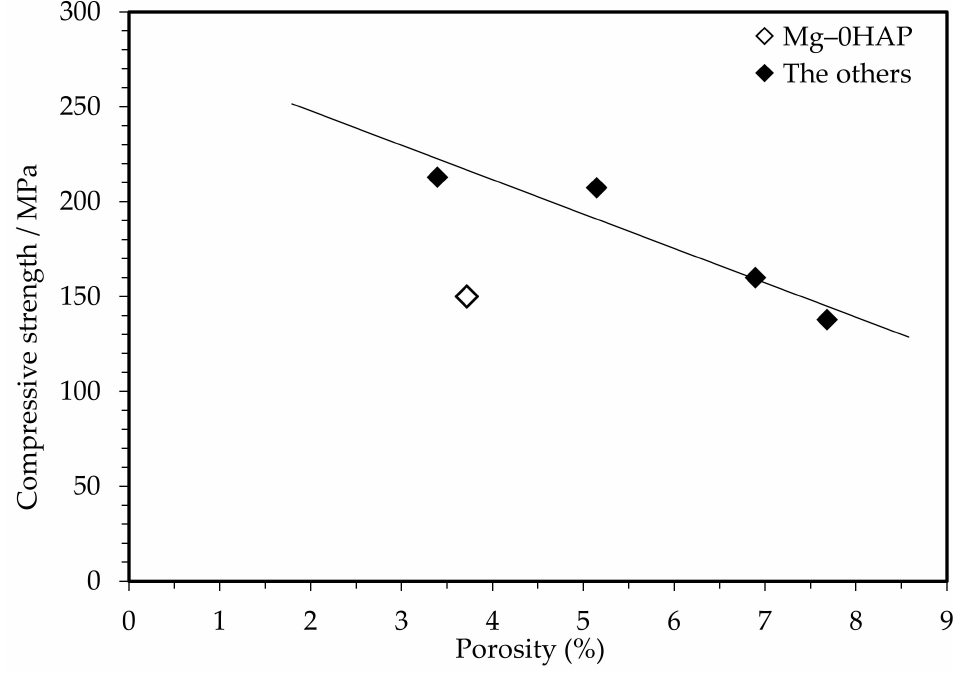
Figure 9. Relationship between the compressive strength and the porosity showing the strong negative correlation in all samples containing